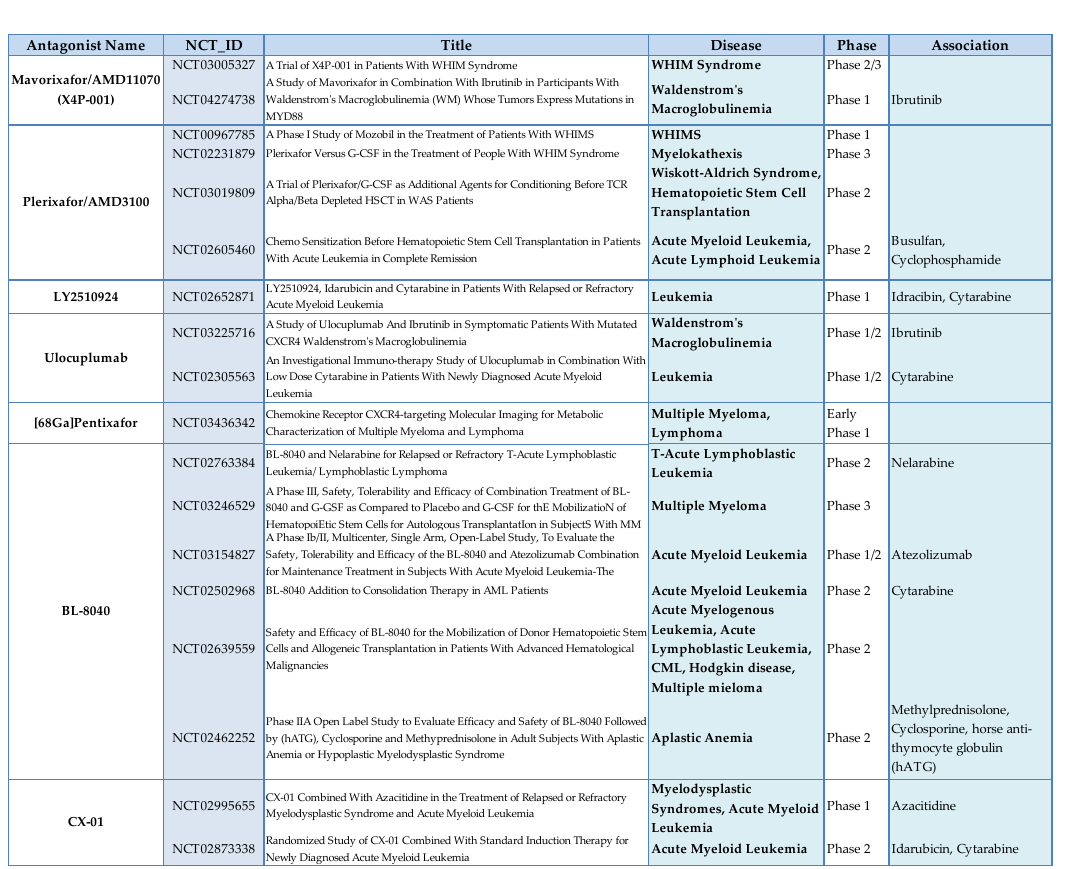
Figure 4. CXCR4 antagonists in hematological tumors.